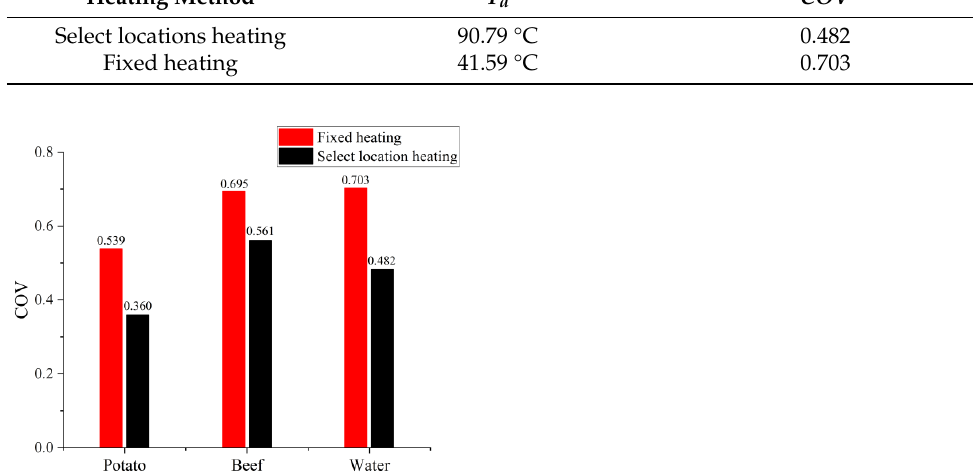
Figure 16. Comparison of COV of different materials in select locations heating and fixed heating.